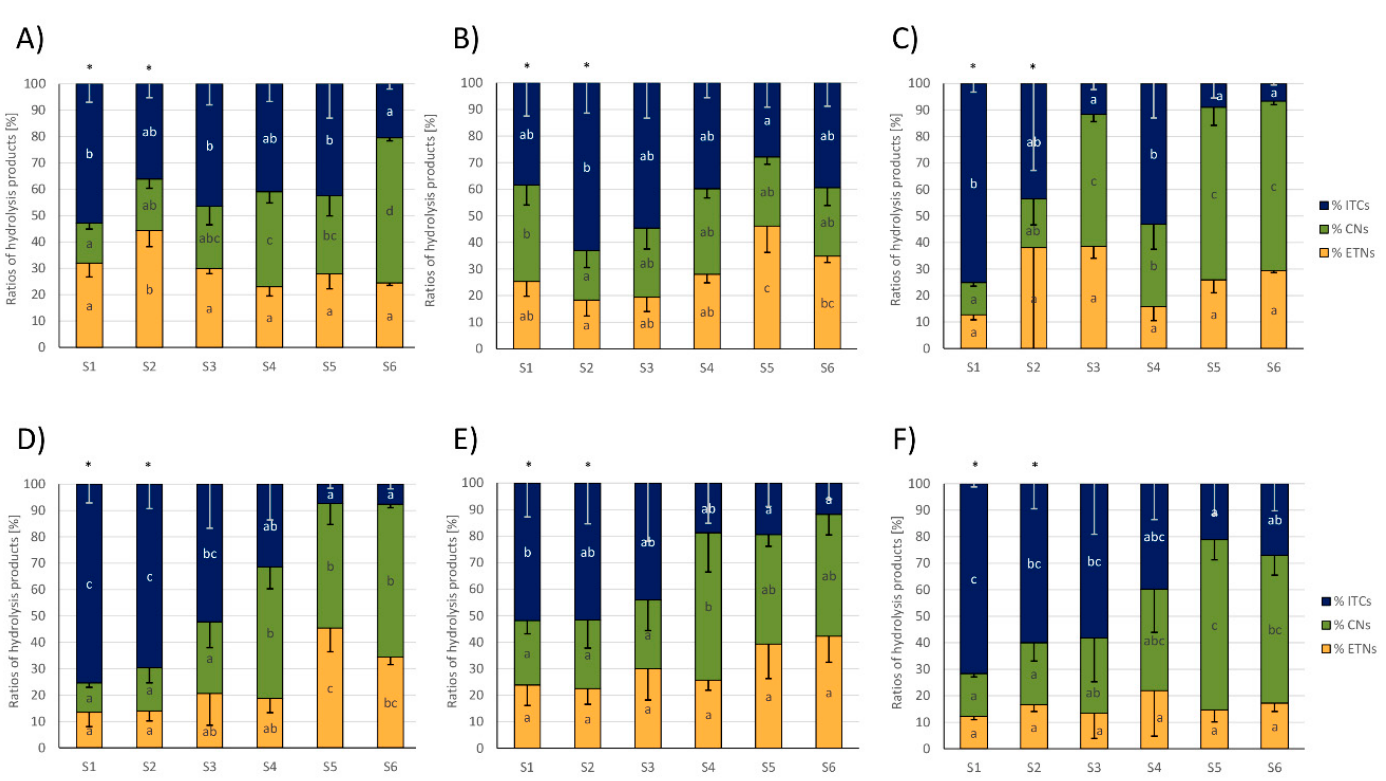
Figure 4. Total glucosinolate (GLS) hydrolysis product ratios (percentage of total isothiocyanates (ITCs), nitriles (CNs), and epithionitriles (ETNs)) from white ( A – C ) and red cabbages ( D – F ) from conventional ( A , B , D , E ) and organic supermarkets ( C , F ) on di ff erent sampling dates (S1–S6). Exact sampling dates can be found in Table 1. ( A , D ) Represent conventional supermarket 1 (CON 1 ), ( B , E ) stand for conventional supermarket 2 (CON 2 ), and ( C , F ) show results from organic supermarket 1 (ORG 1 ). Each color in the bar of the given bar chart represents the mean minus standard deviation (SD) of the GLS hydrolysis products from three cabbage heads from the same supermarket ( n = 3). Di ff erent lower case letters indicate significant di ff erences in means between the ratios of total ITCs, CNs, and ETNs in di ff erent samples, as tested by ANOVA and Tukey’s HSD test at the p ≤ 0.05 level. FW: Fresh weight. * Samples were analyzed from 1 g of sample homogenate (instead of 0.5 g).